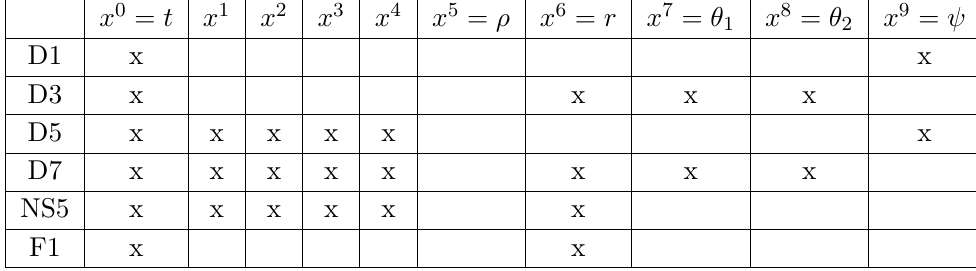
Table 1 . Brane set-up associated to our solutions. x 0 corresponds to the time direction of the ten dimensional spacetime, x 1 , . . . , x 4 are the coordinates spanned by the CY coordinates parametrising the S 2